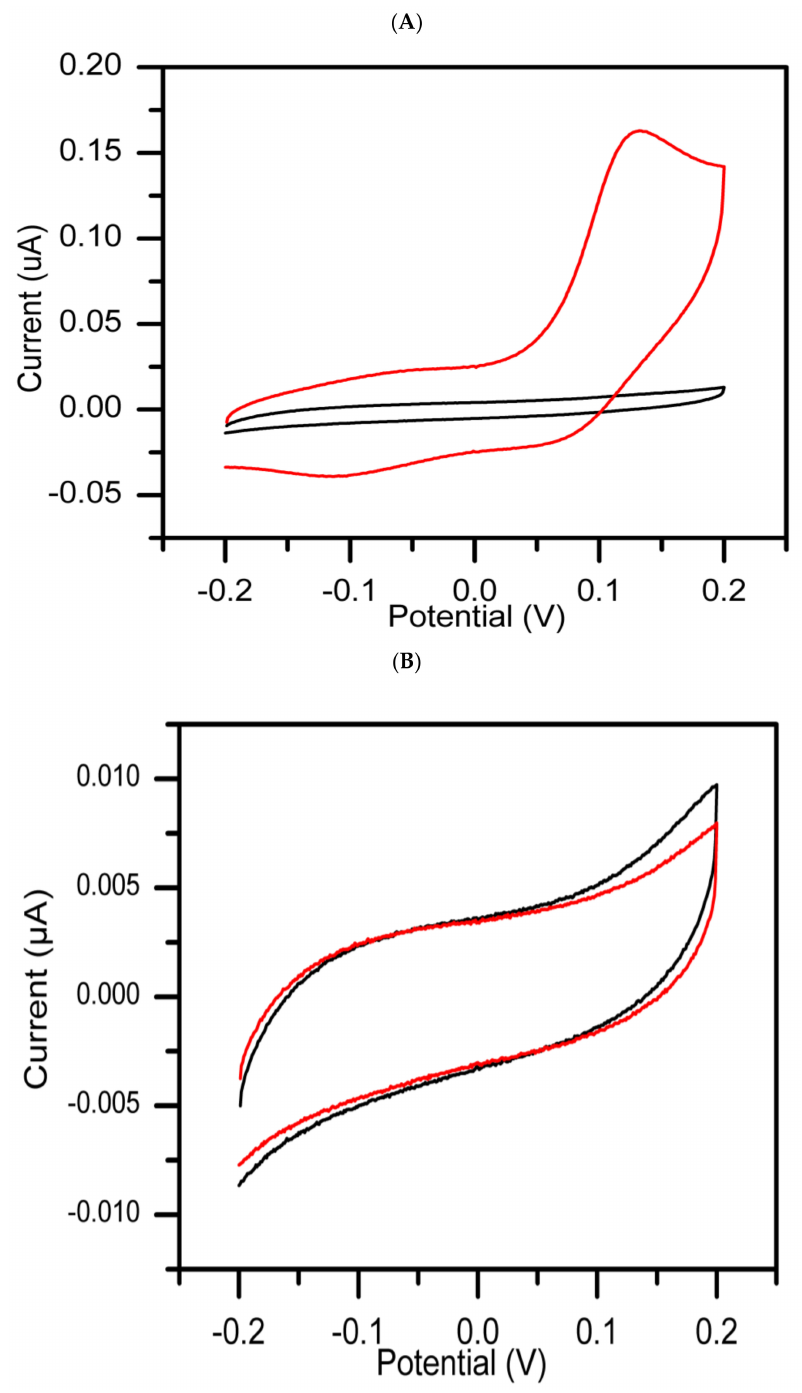
Figure 2. CVs recorded at 25 mV/s for the reaction mixtures of negative control ( A ) and positive control ( B ) experiments in the presence of 50 mM PBS (pH 6.5), after consecutive addition of DMSO, tyrosinase and tyrosine. The CV recorded at 0 min (black curve) and at 30 min (red curve),